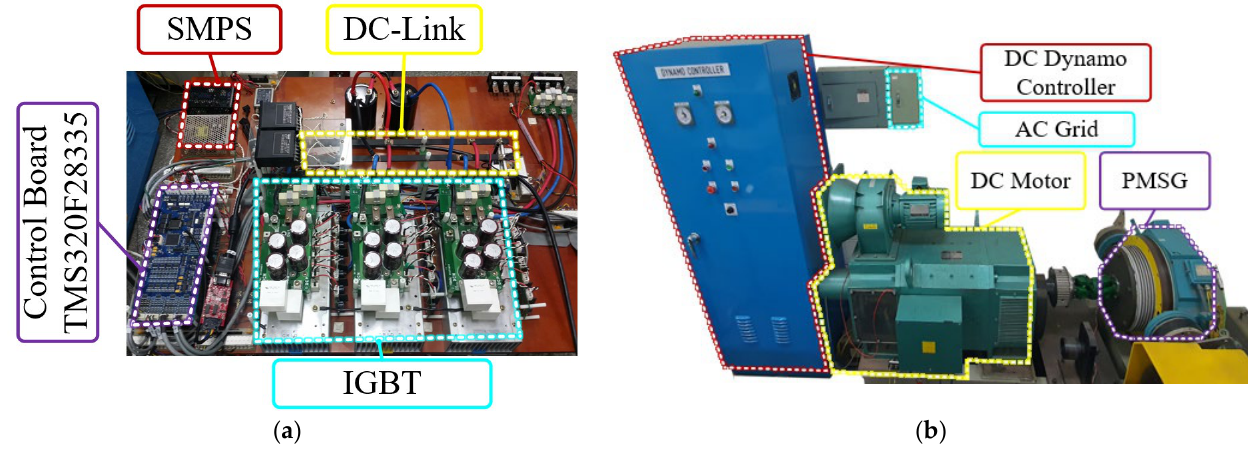
Figure 19. Wind Turbine (WT) generation system: ( a ) 3-level NPC converter; ( b ) M-G set.